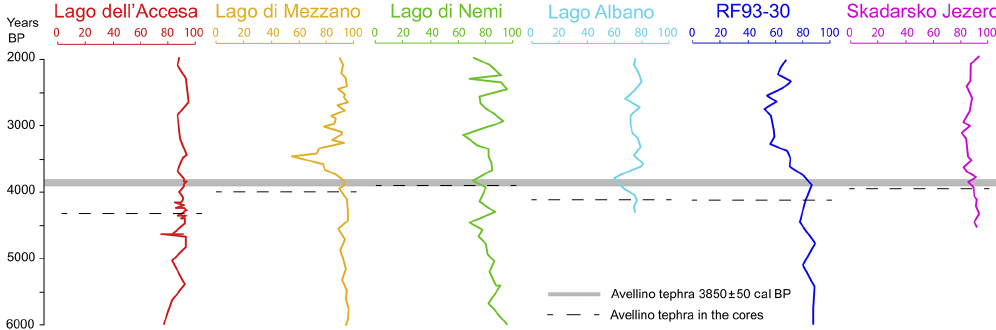
Figure 6. Compilation of pollen records containing the Avellino tephra layer (dated at approximately 3.8ka; for review, see Zanchetta et al., 2018). All the records are plotted with their original age model: Lago dell’Accesa (Drescher-Schneider et al., 2007); Lago di Mezzano (Sadori, 2018); Lago Albano and Lago di Nemi (Mercuri et al., 2002); RF93-30 (Mercuri et al., 2012). For core RF93-30, the correlation with Avellino tephra is not certain (Lowe et al.,